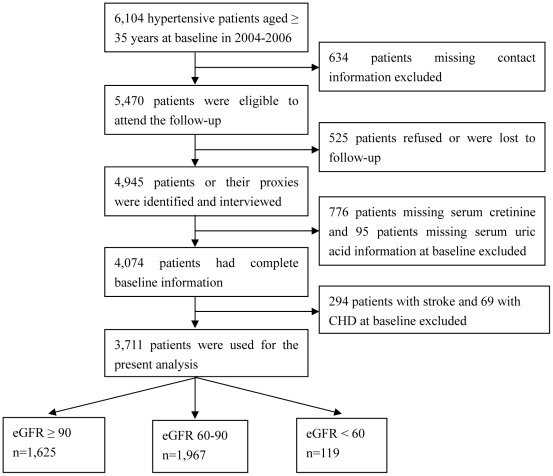
Flow chart of participant recruitment and derivation of the population used in the final analysis.